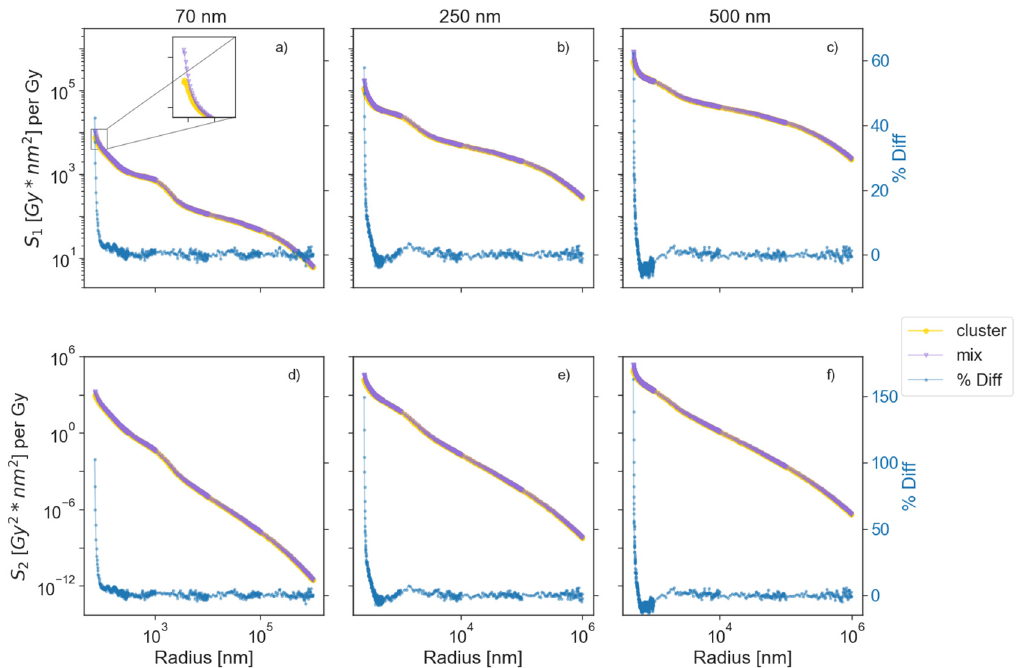
Figure 3. Upper row ( a – c ) shows the behaviors of S 1 for a cluster of GNPs and a MixNP for all sizes, along with the %Diff between them (blue). S 1 represents the dose in a spherical shell and thickness of dr integrated over the surface of a circle of radius r . Due to the slow decrease of S 1 along the radius, we scored the dose far away from the nanoparticle. Lower row ( d – f ) shows the change in S 2 along the radial distances. S 2 is defined similarly to S 1 , but using the dose squared in the surface integral. Due to the closeness of the values of S 1 for the full cluster and a MixNP, a zoomed-in view was added in ( a ).